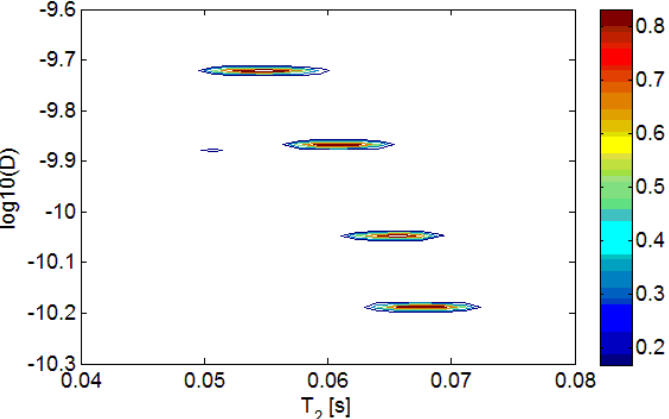
Figure 5. D-T distribution of red palm and extra virgin olive oil mixtures. From top to 2 bottom, they are pure red palm oil, 10% red palm oil, 20% red palm oil and pure extra virgin olive oil,